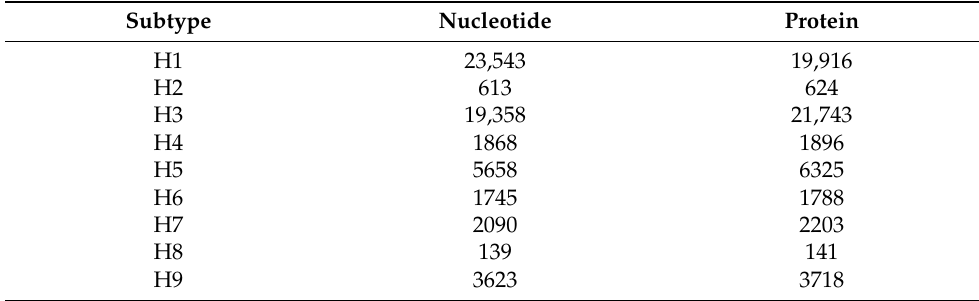
Table 1. Data size of the